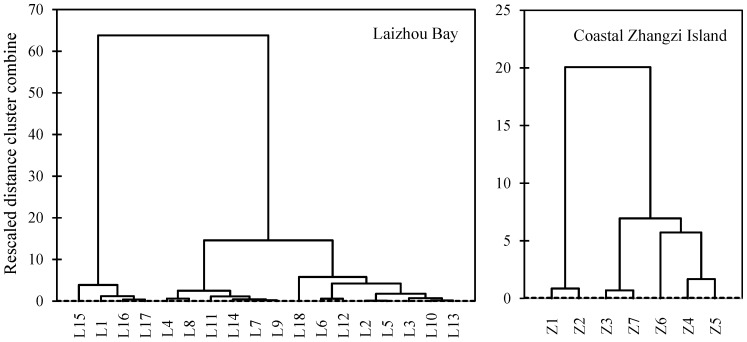
Dendrogram showing clustering of sampling sites in the two studied areas.